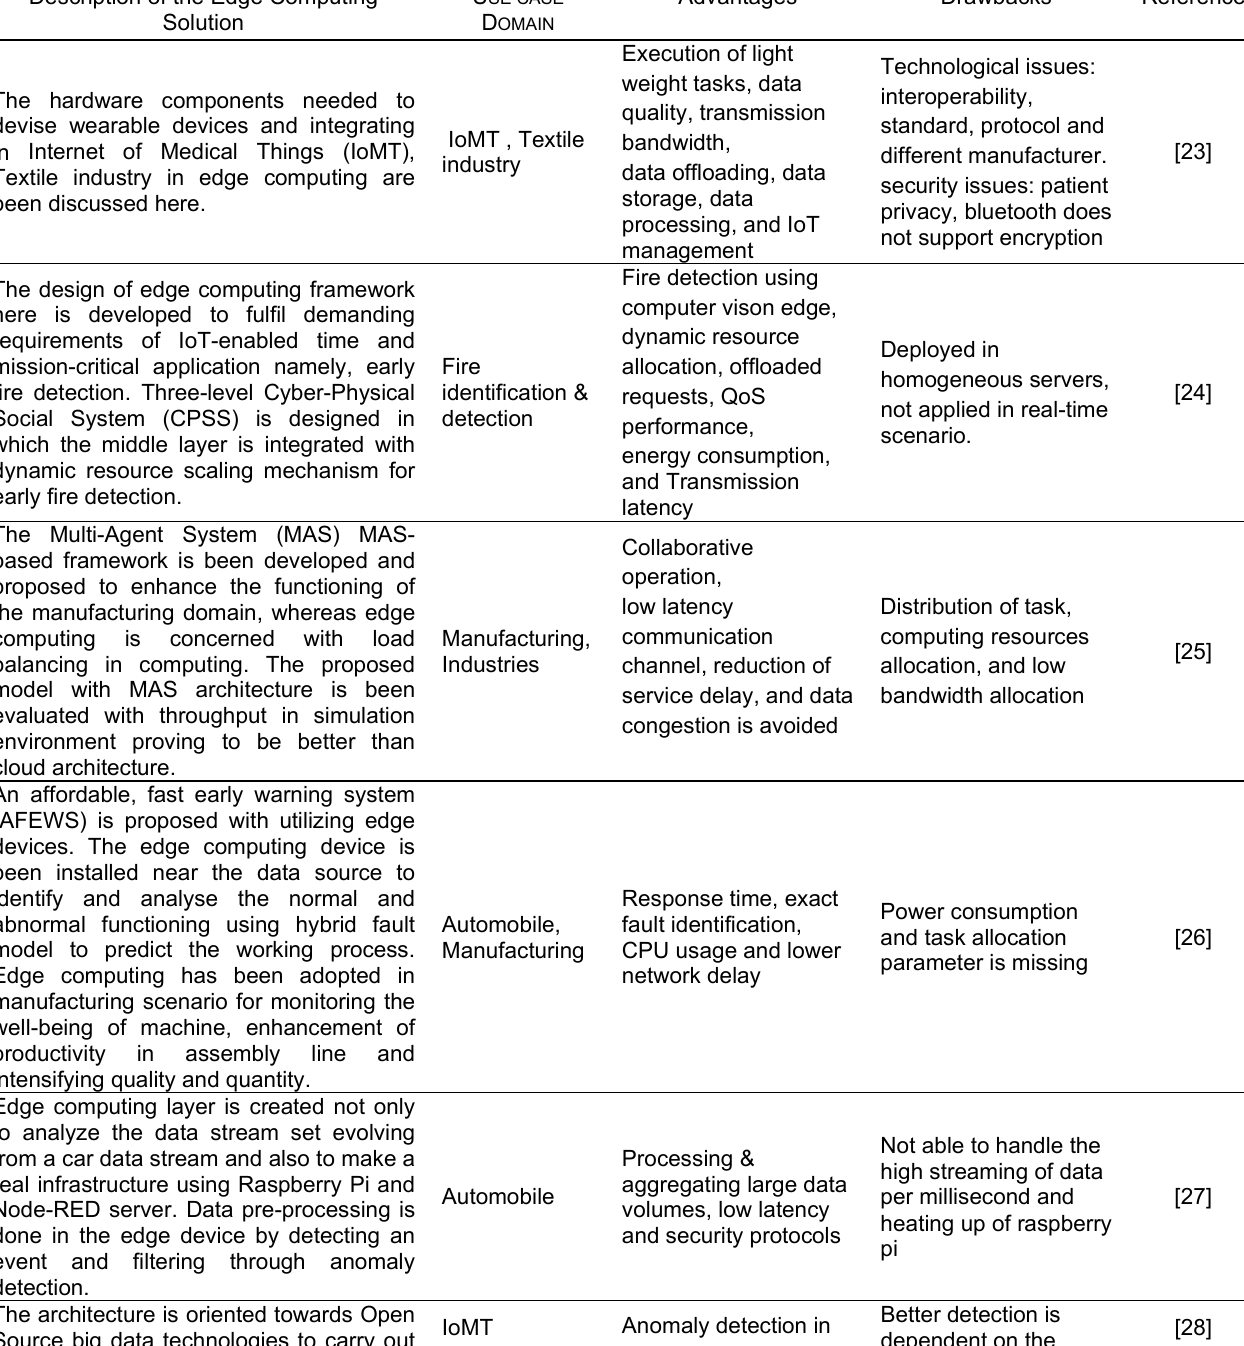
Table 1. Advancements in edge computing